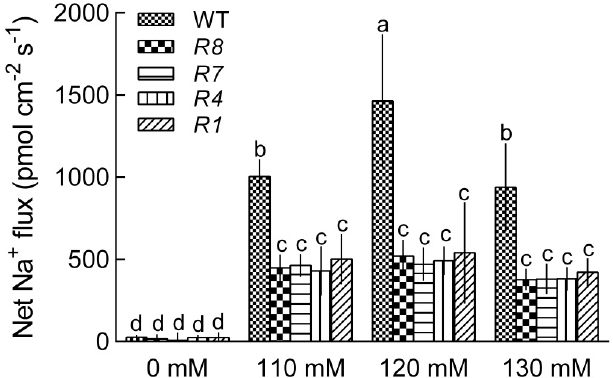
Figure 6. Na + flux in GL1 and CPK12 -RNAi plants. Seeds were germinated for one week in a vertical direction on MS agar medium containing 0, 110, 120, 130 mM NaCl. Continuous NMT recording were applied at the meristem region of the root tips. Each column is the mean of six independent seedlings; bars show the standard error of the mean. Columns marked with letters in the same group indicate significant differences at p < 0.05.